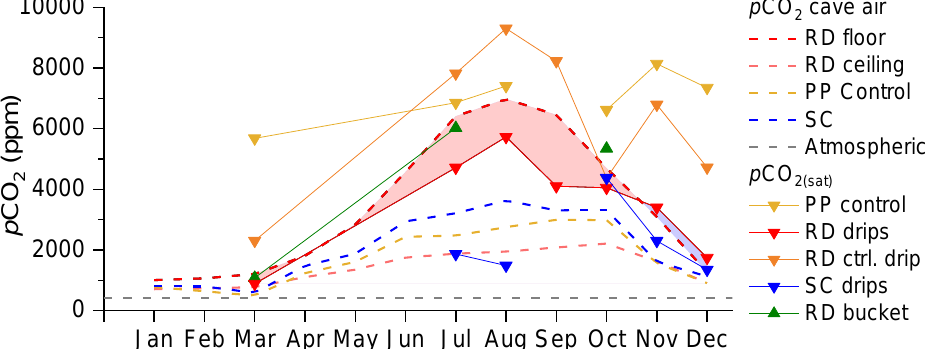
Figure 13. Variation in the p CO 2(sat) values ( p CO 2(eq) of the solution forced to SI cc = 0; solid lines) for different drips in Pisani Passage compared to the p CO 2 dynamics of the cave air in the Red Hall summarised on a monthly scale (dashed lines). The red shading indicates the range of potential dissolution in the Red Hall (i.e., water p CO 2(sat) < p CO 2 of the cave air), while the blue shading indicates precipitation.